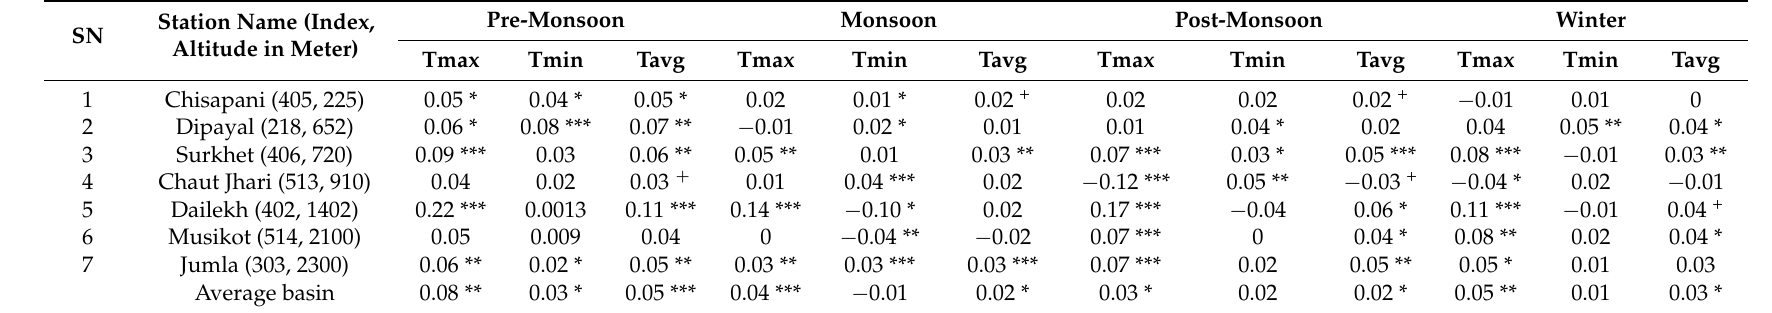
Table 2. Temperature trend ( ˝ C/year) in different elevations of the